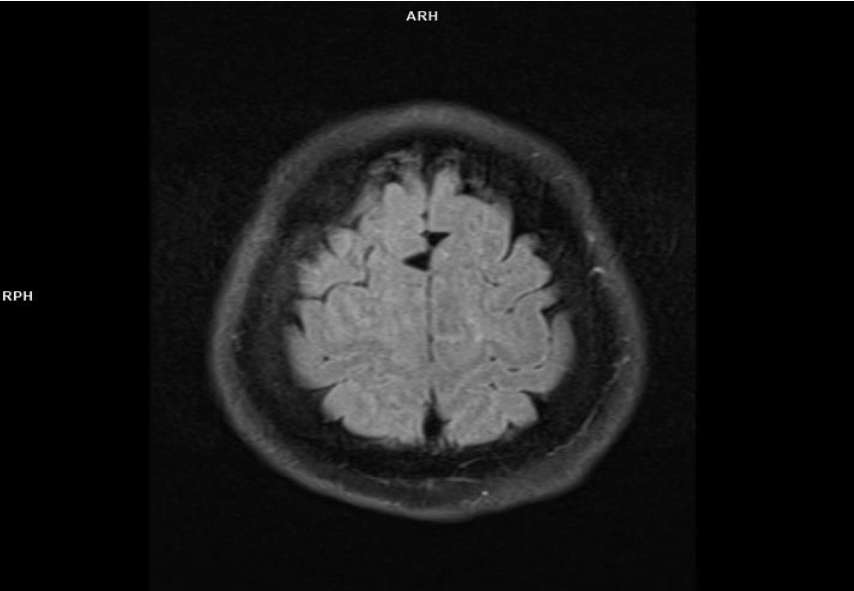
Figure 2. Bilateral shallowed sulci on the convexities of the brain — Flair sequence (MRI imaging).